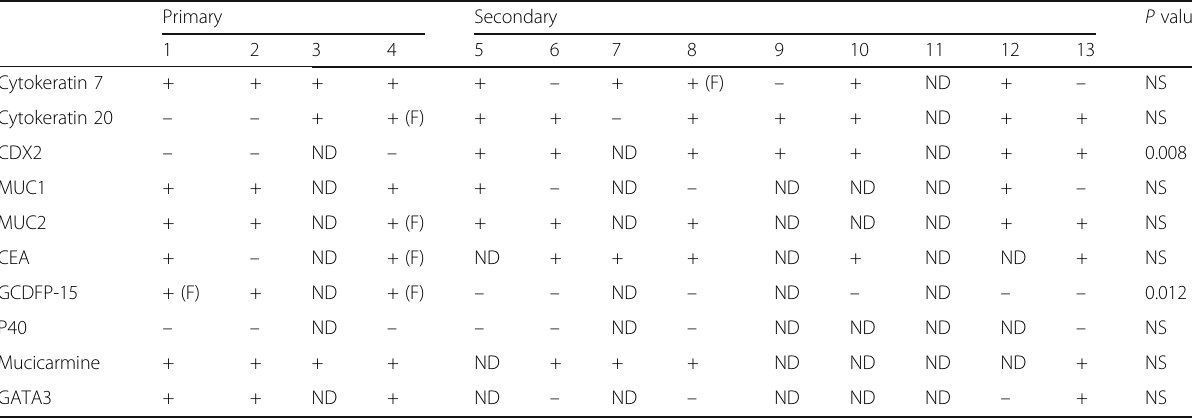
Table 2 Immunohistochemical profile of perianal Paget ’ s disease